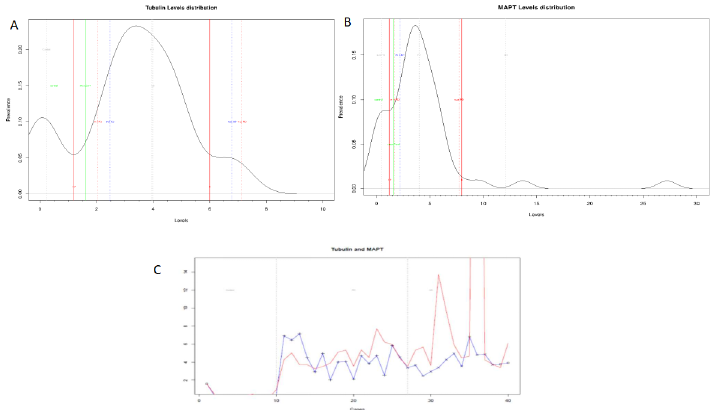
Fig 3. Distribution curves of AIAs against tubulin (3A), tau (3B) and the combination of tubulin and tau (3C) in different groups. Curves showed possible differentiation between cases and controls (3A and 3B) and the possibility of identifying profiles specific for PD and AD (Tubulin in blue and Tau in red)